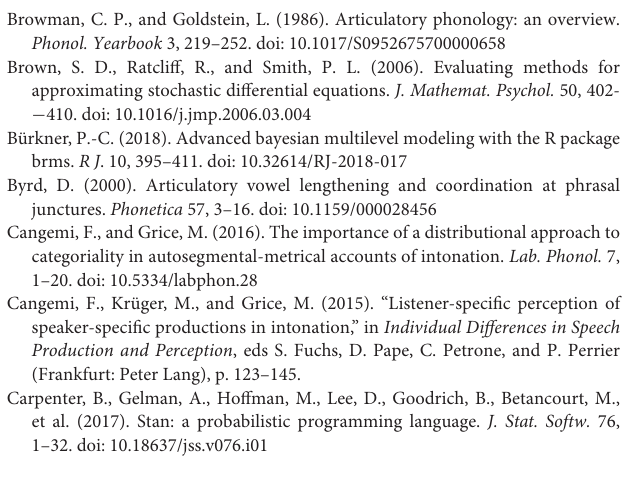
Figure S1 | Example screen from experiment during a trial with contrastive focus condition. Figure S2 | Distributions of the maximal lip aperture (z-scored) for all speakers. Figure S3 | Distributions of the lowest tongue body position (z-scored) for all speakers. Table S1 | Target words (all nonce words). Table S2 | Tools with English